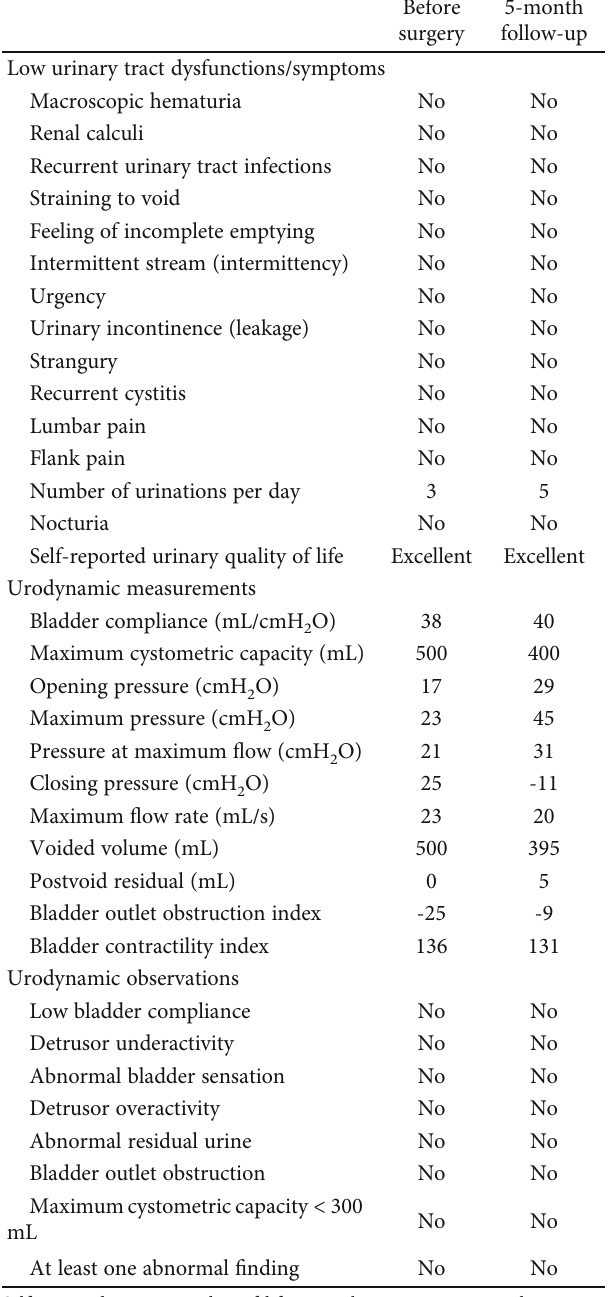
Table 3: Urinary system